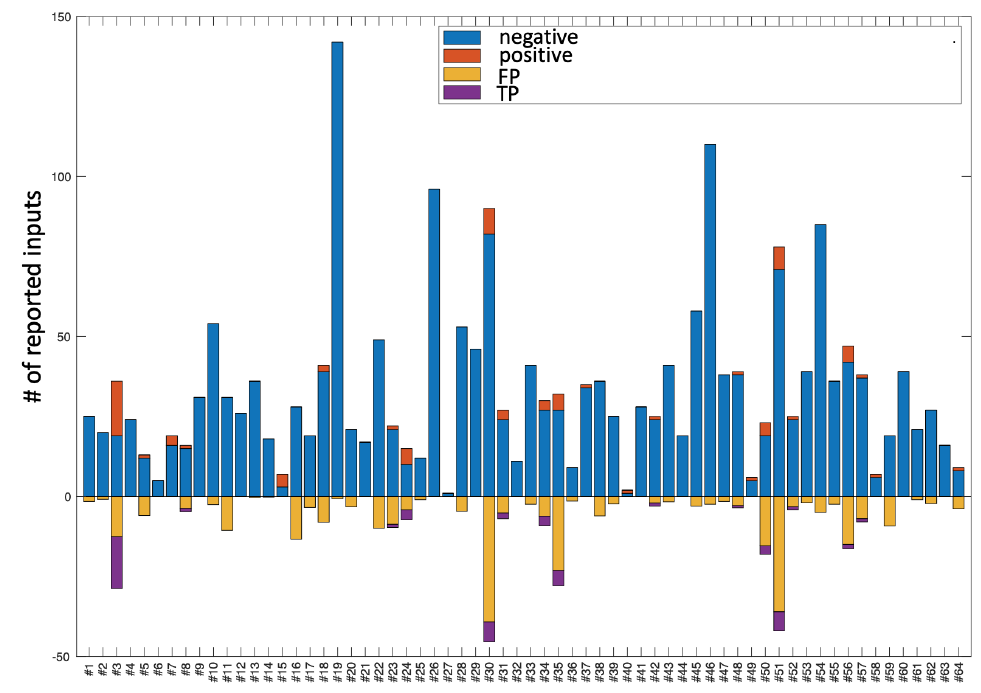
Figure 5. The positive part of the graph corresponds to the representation of the database in terms of the number of entries labelled as positive and negative for each user. The negative part of the graph corresponds to the TPs and TNs obtained in the Leave-One-Subject-Out Cross-Validation